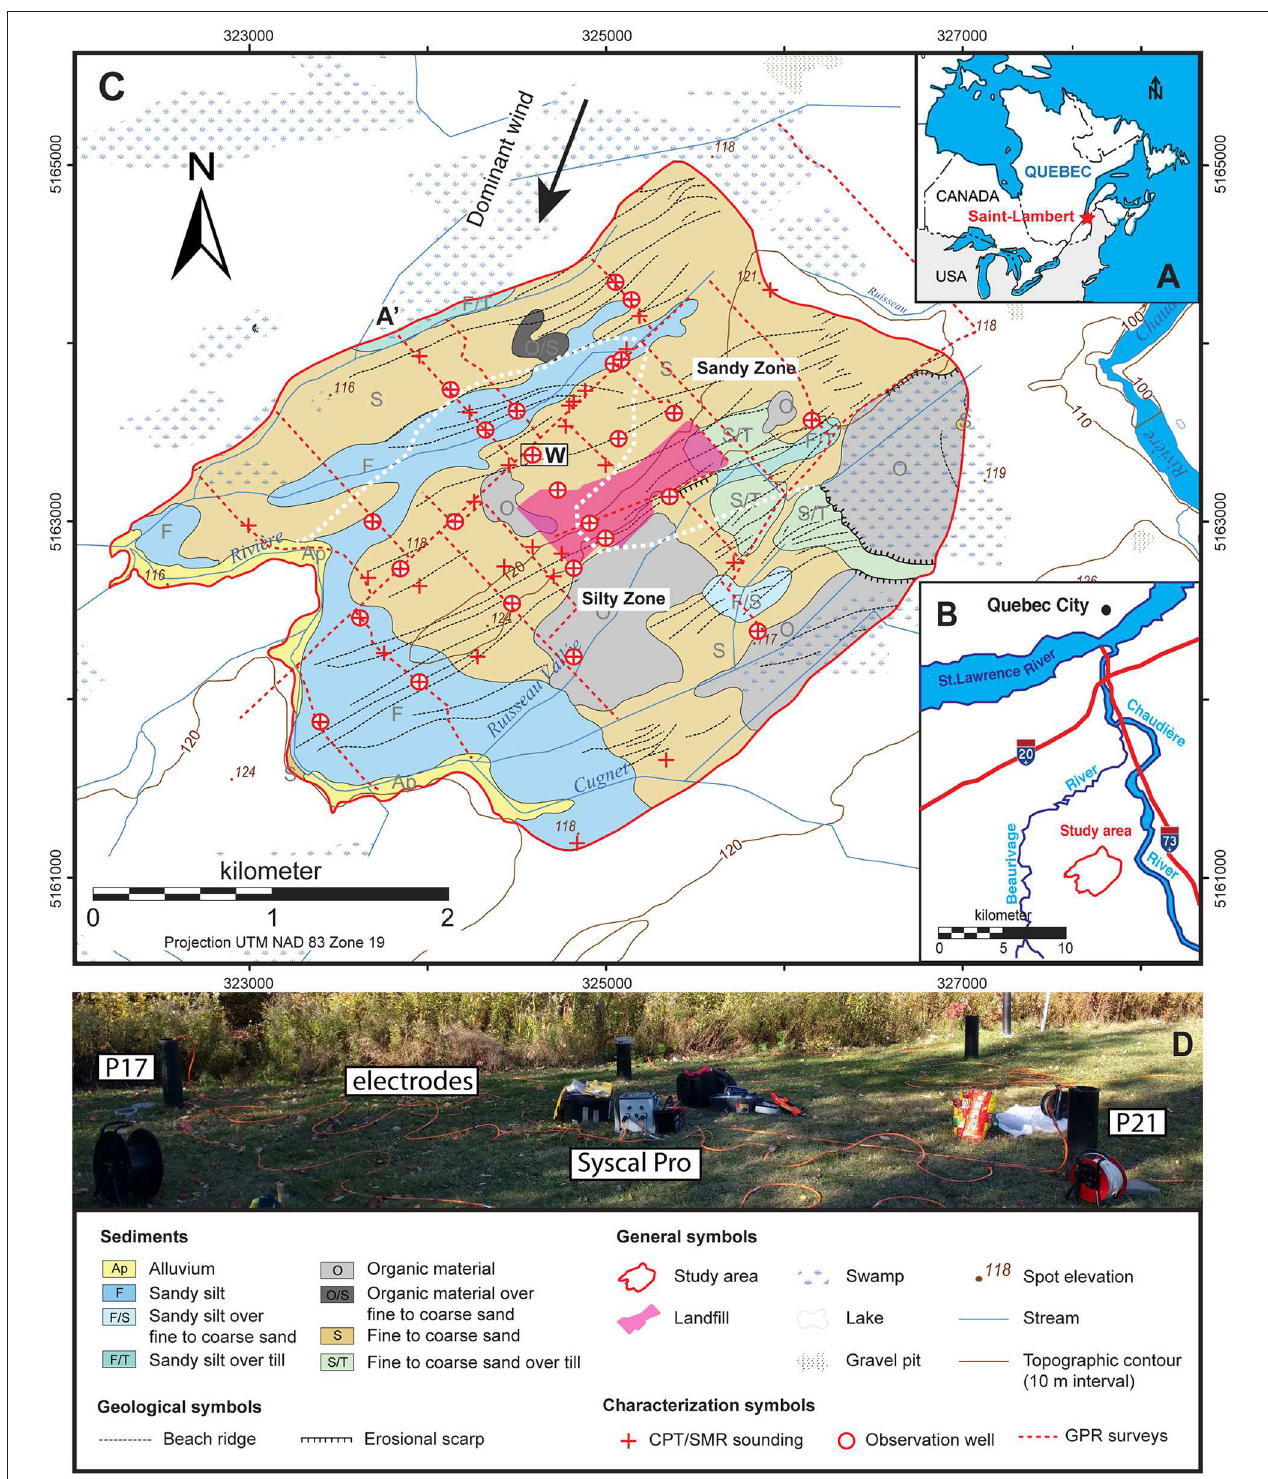
FIGURE 1 | Saint-Lambert-de-Lauzon (SLdL) study area. It is located (A) in Québec, Canada, (B) 30 km south of Québec City between to the Chaudière and Beaurivage rivers. (C) Geology and characterization details of the study area. (D) Anisotropic hydraulic and electrical tomography site corresponding to the “W” on (C) . ERT acquisition is done using an IRIS Syscal Pro system. Nine and Eight electrodes are, respectively, immersed in P17 and P21. Seventeen electrodes are planted between P17 and P21. P17 and P21 are separated by 8 m, electrodes separation is 1 m inside the wells and 0.5 m at the surface. Adapted from Paradis et al. (2015b).